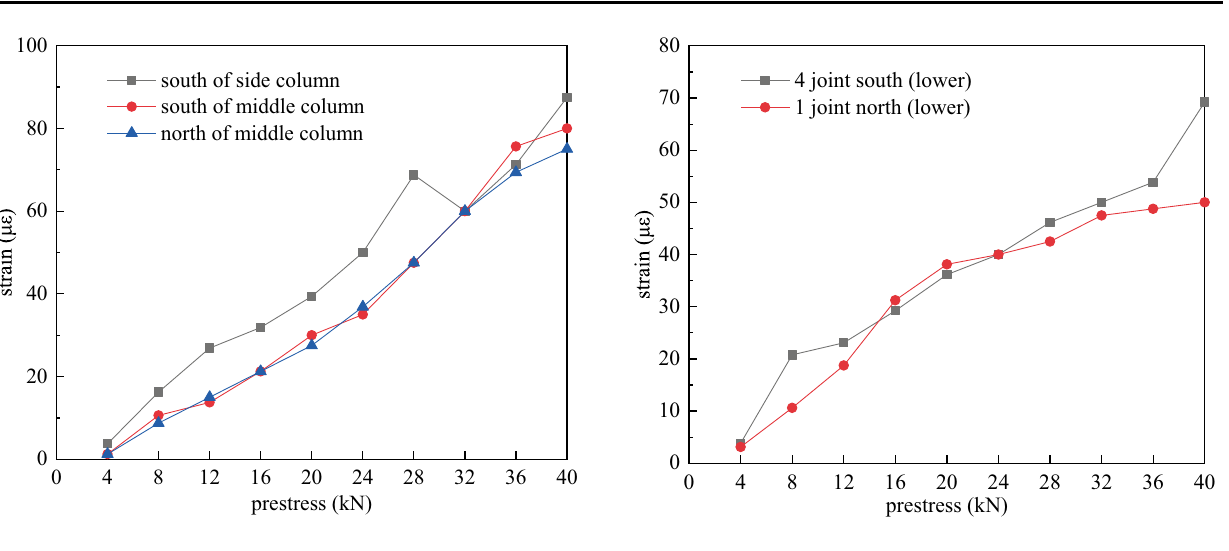
Fig. 26 Micro strain